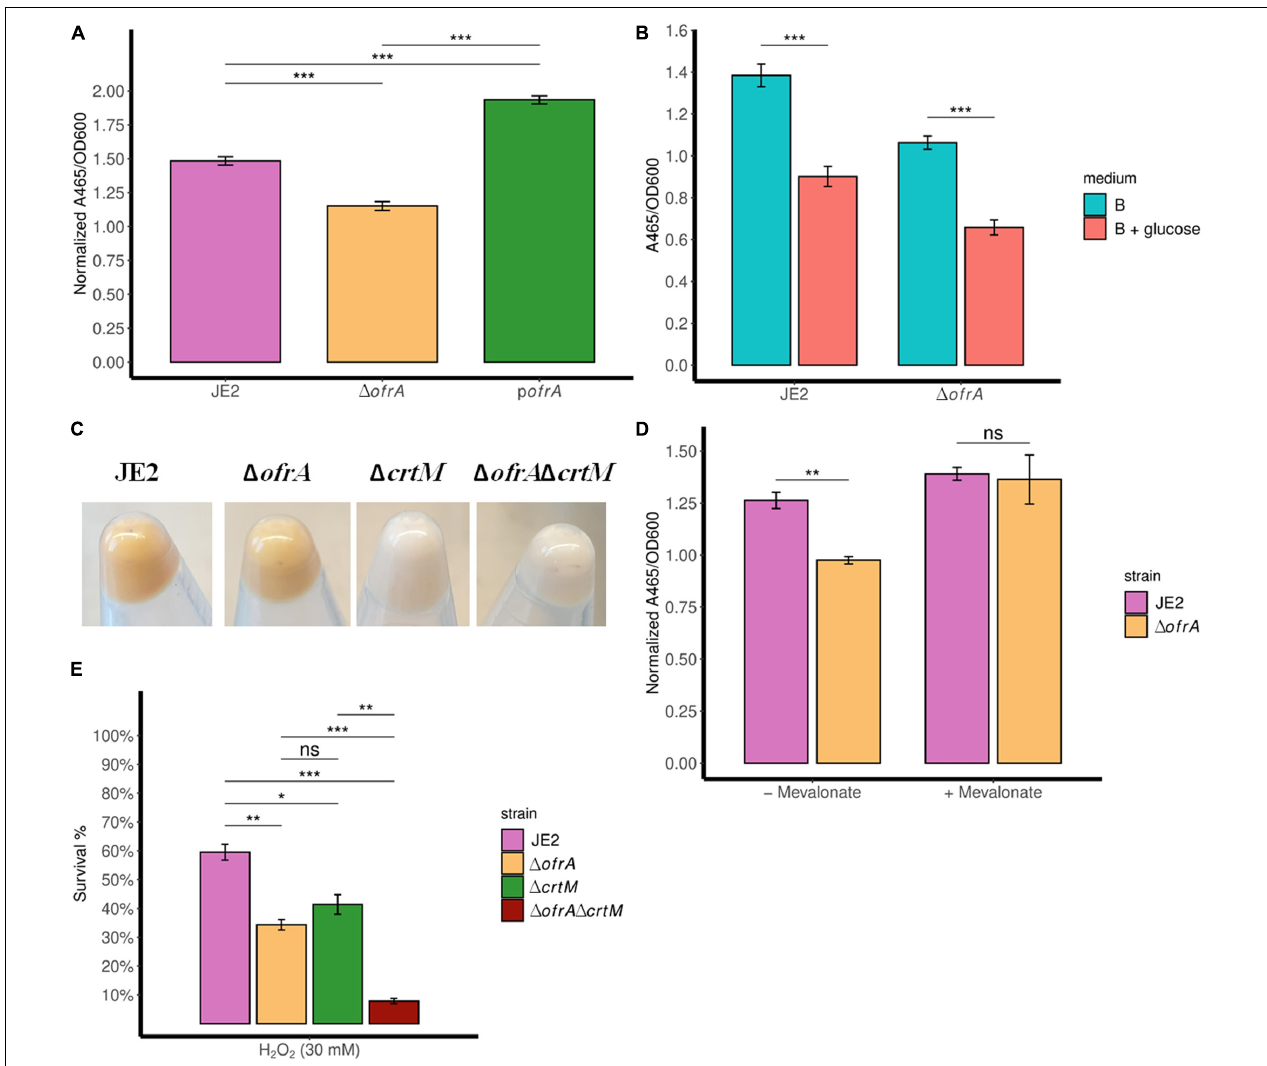
FIGURE 5 | ofrA mutation decreases STX production via the upper mevalonate pathway but cannot solely explain ROS hypersensitivity. Staphyloxanthin assay showing STX levels in TSB medium (A,C) , B-medium (B) , and RPMI (D) . The strains were grown in overnight culture in the respective medium without any supplementation. Then, we diluted the overnight cultures 1:100 in fresh medium without or with supplementation; 0.5% glucose (B) or 1 mM mevalonate (D) . After 24 h, the bacteria were collected and washed with sterile water. OD 600 were recorded for normalization. STX was extracted using methanol (refer to section “Materials and Methods”). A 465 were used for measuring the extracted STX. Error bars represent the standard error of the means (A,D) and standard deviation (B) of four biological replicates. Statistical analysis was carried out using unpaired two-tailed Student’s t -test (B,D) or one-way ANOVA and pairwise t -test with Bonferroni p -value adjustment (A) ; ns, not significant; * p < 0.05; ** p < 0.01; *** p < 0.001. (E) Bacterial survival assays showing crtM mutation additive effect to ofrA mutation in ROS hypersensitivity. The strains were grown in overnight culture in RPMI medium. We diluted the overnight cultures 1:100 in fresh RPMI until mid-logarithmic phase. Cells were harvested by centrifugation and washed with sterile PBS. OD 600 were adjusted to 0.4. Bacteria were challenged with 30 mM H 2 O 2 . After 1 h of exposure to 30 mM H 2 O 2 , viable cells were diluted in PBS after catalase treatment for residual H 2 O 2 . Samples were taken from the untreated control